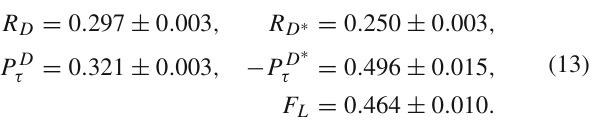
Table 1. Our nominal best-fit point, obtained in the 3 / 2 / 1 model, is presented in Table 2. Due to the non-Gaussianity of the posterior we refrain from providing linear